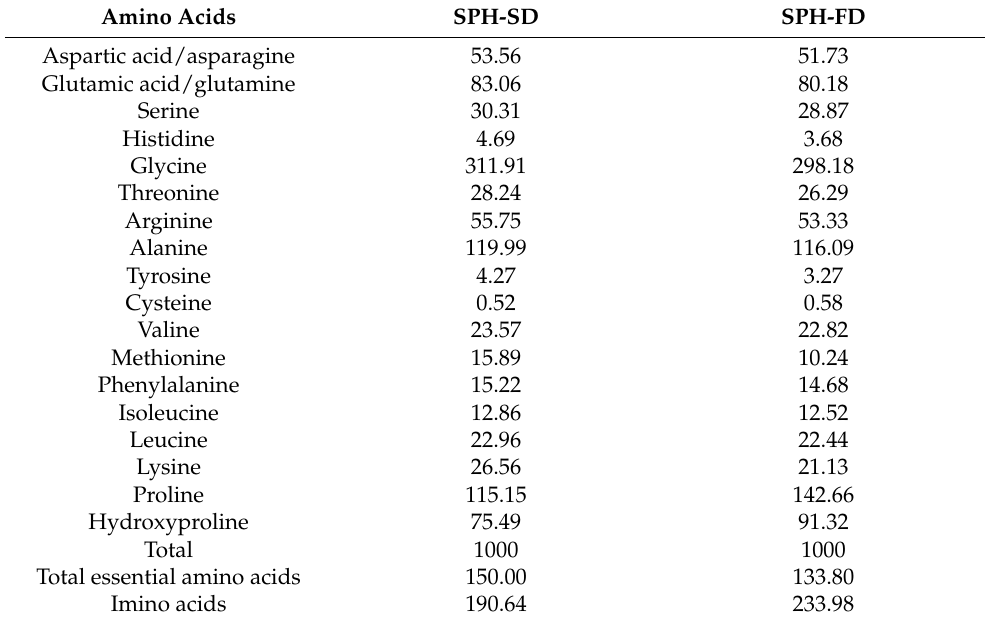
Table 2. Amino acid composition of SPH-SD and SPH-FD samples (results are expressed as residues/1000 total